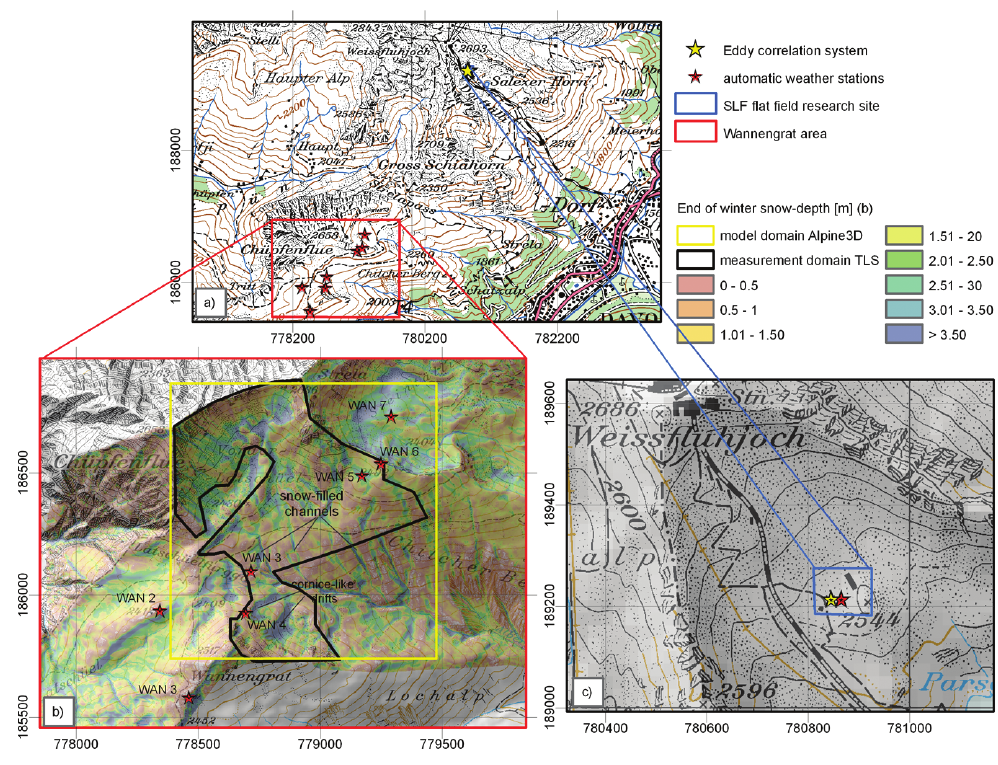
Fig. 1. Overview of the study sites (a) , detailed maps of study sites Wannengrat area (b) , and SLF flat field research site Versuchsfeld Weissfluhjoch (c) . Borders of the measurement domain (black box in panel b) vary with snow coverage. The x- and y axes give Swiss coordinates in meters. (base map: Pixelkarte PK25 swisstopo